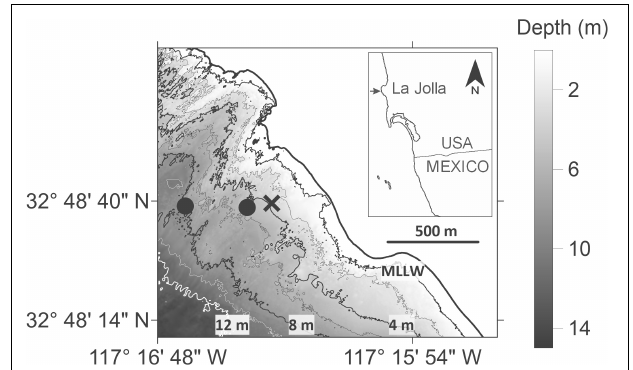
FIGURE 1 | Inset showing Bird Rock study site in La Jolla region (indicated by arrow), CA, United States. Map shows nearshore bathymetric isobaths from Mean Lower Low Water (MLLW) to 12 m depth at 2 m isobath intervals. Black ‘X’ represents the 4 m deep larval and CTD sampling station ( ∼ 280 m from shore); the two black circles represent the 5 m- and 8 m-deep temperature mooring stations ( ∼ 400 and ∼ 800 m from shore respectively); Nortek Aquadopp Profiler (ADCP) was also deployed near the 5 m deep temperature mooring at ∼ 6 m depth (circles overlap). Lidar bathymetry data from the 2013 NOAA Coastal California TopoBathy Merge Project https://data.noaa.gov/ dataset/2013-noaa-coastal-california-topobathy-merge-project.